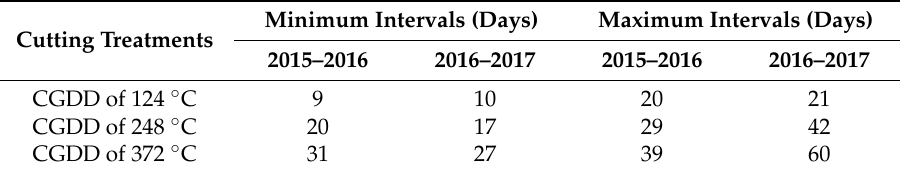
Table 3. Time intervals between cuttings for all treatments.